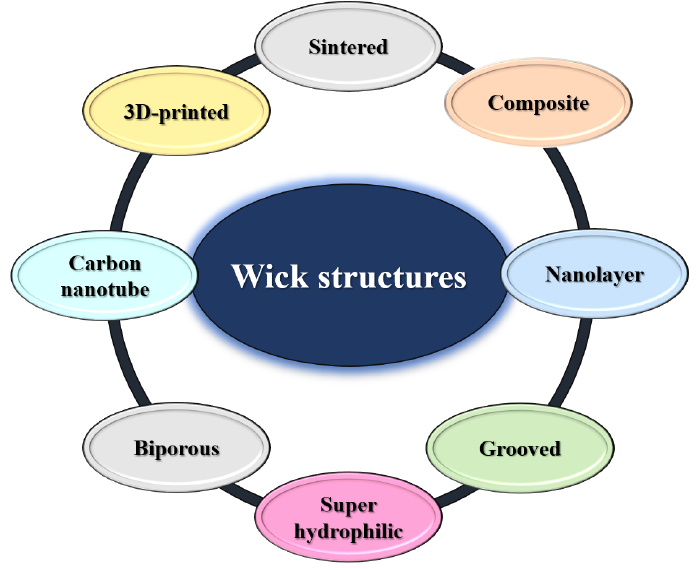
Figure 4. The most common wick types are sintered powder, metal meshes, composite wicks, sin- tered metal fibers, grooved wicks, additively manufactured wicks, mesh-groove wicks, and bi-po- rous